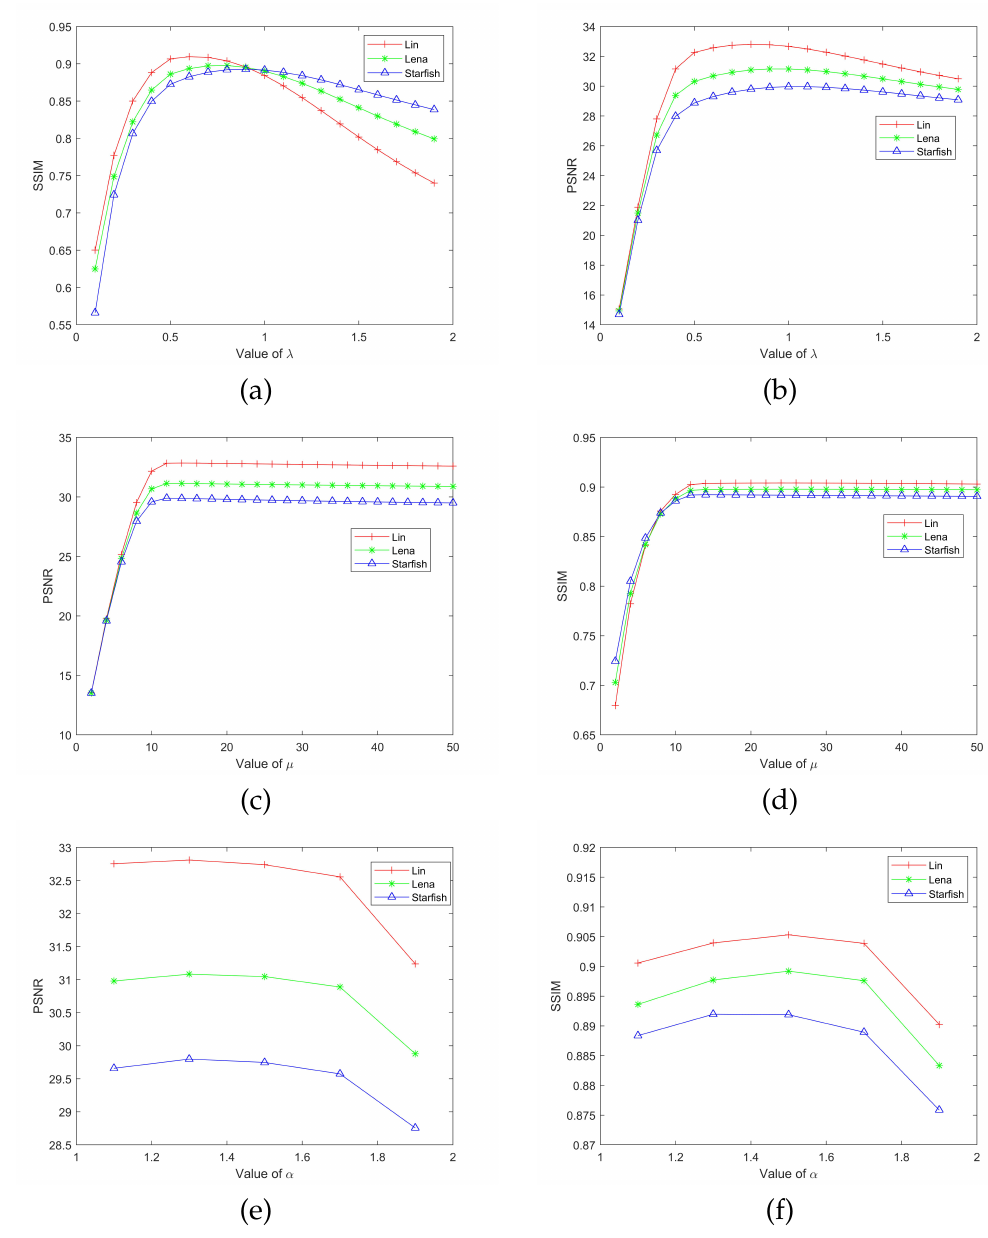
Figure 2. ( a – f ) The values of PSNR and SSIM with respect to the parameters λ , µ , α Figure 2. The values of PSNR and SSIM with respect to the parameters λ , µ , α